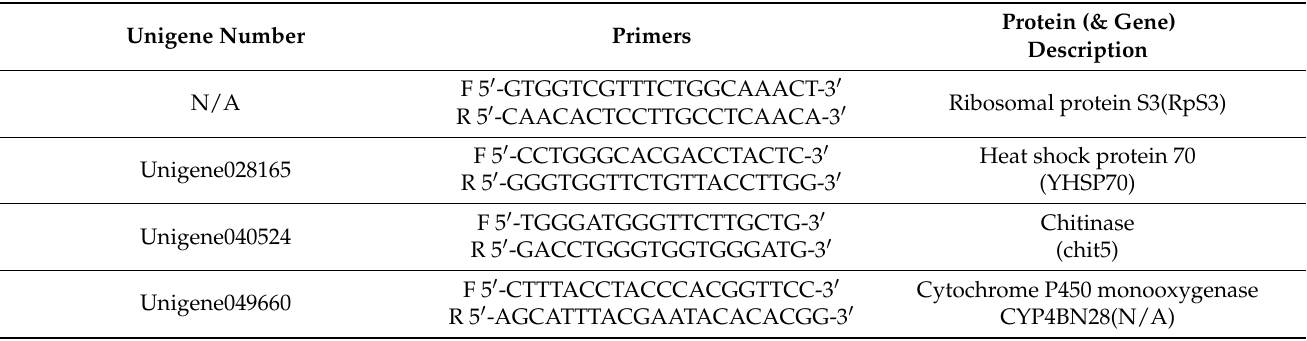
Table 1. Primers used for the quantification of mRNA expression by